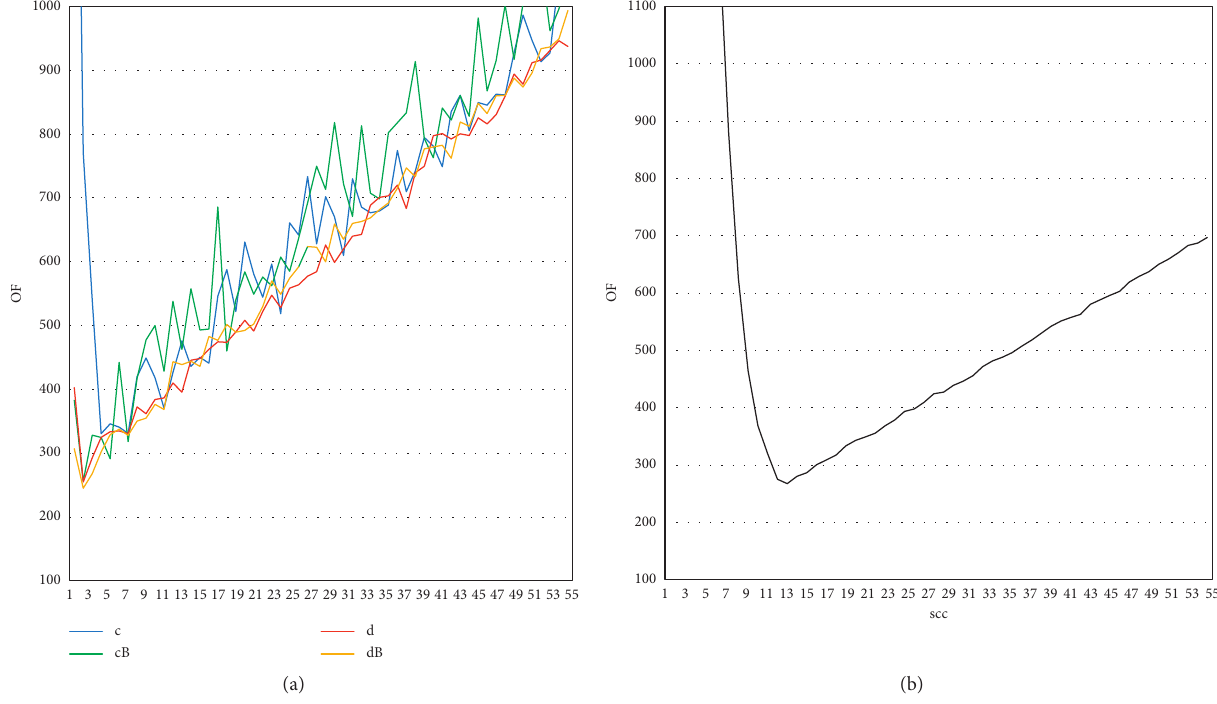
Figure 4: Trend of the objective function with respect to the Check-in counters variables and Security Control gates for only one